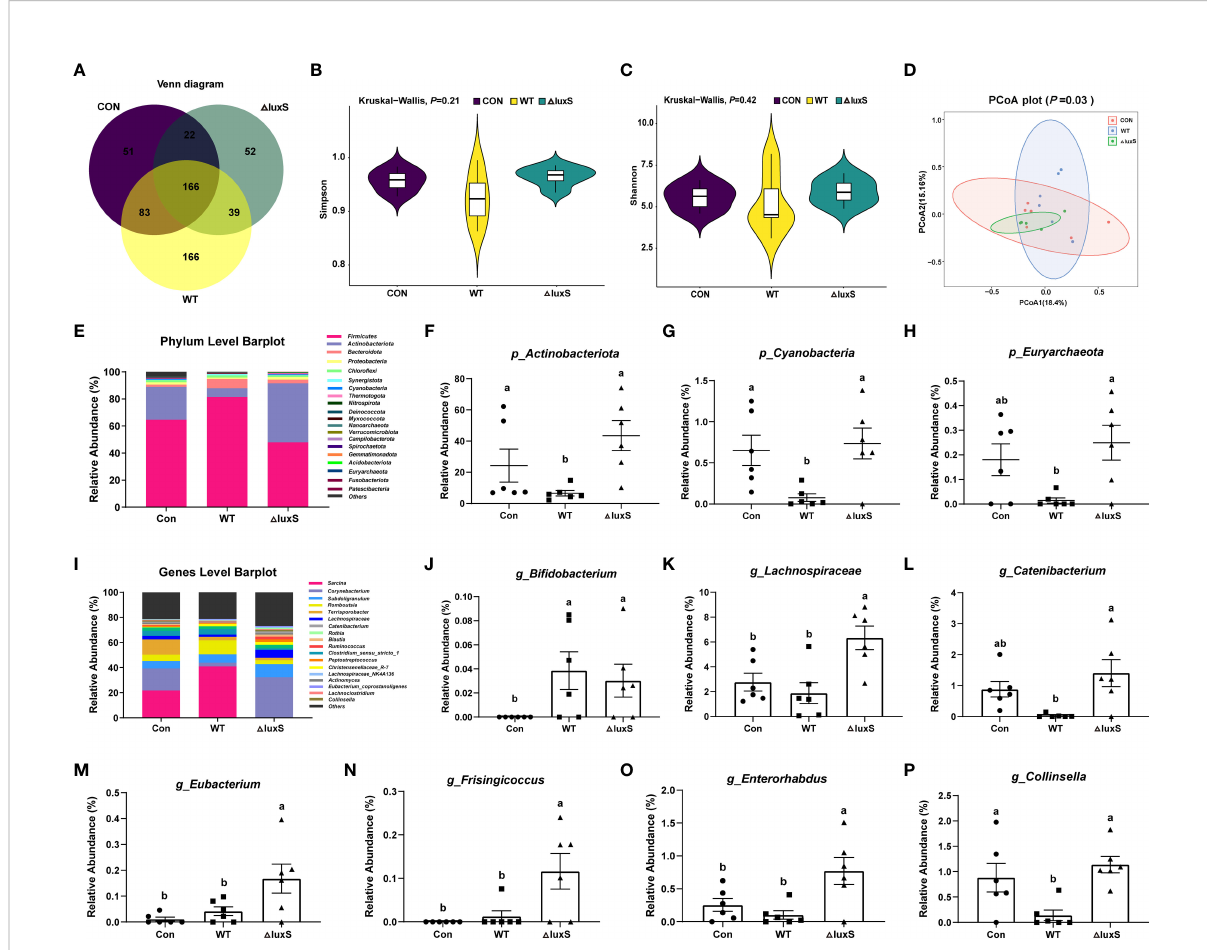
FIGURE 2 The high-throughput sequencing of 16S rRNA gene in ileum contents. (A) Venn disgrams for bacterial OTUs compositions. (B, C) a diversity analysis. a diversity was tested by Kruskal-Wallis. (D) b diversity analysis. (E) Comparison of the phylum level. (F-H) Differential bacteria at the phylum level. (I) Comparison of the genus level. (J-P) Differential bacteria at the genus level. Statistical signi fi cance performed using one-way analysis of variance for multiple comparisons. WT and D luxS groups were orally inoculated with 2 mL of LGG wild strain and luxS mutant strain, respectively, for 3 weeks before weaning on day 21. Con group was orally inoculated with PBS. Mean values not sharing common letters are signi fi cantly different ( P <0.05). Values are shown as mean ± SEM,